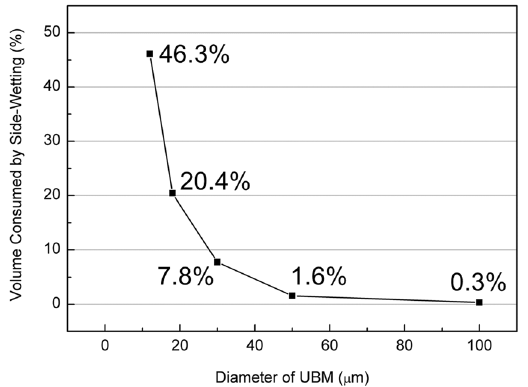
Figure 6. The volume percentage of depleted solder due to the surface diffusion of Sn as a function of UBM